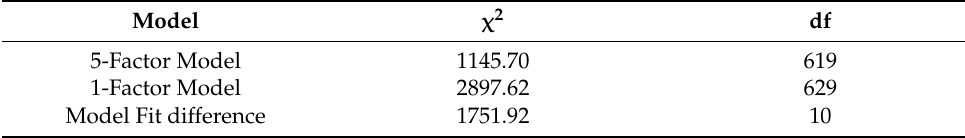
Table 3. Study 1 CFA Model Fit